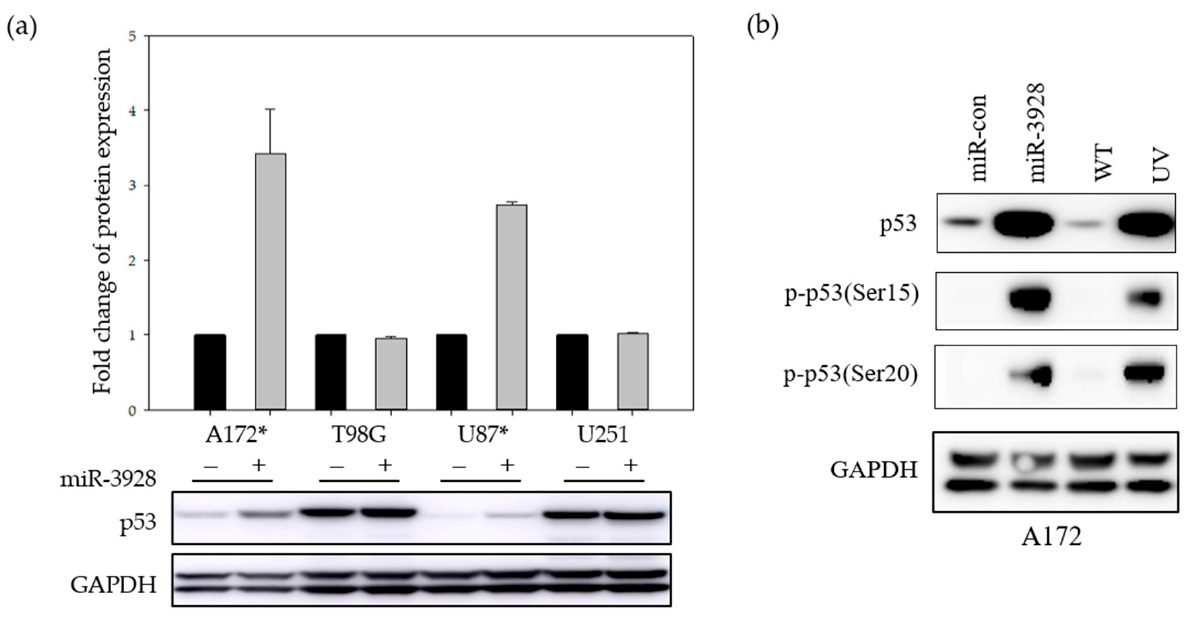
Figure 6. miR-3928 induces the expression and activation of p53 in GBM cells. ( a ) Band intensities from immunoblot replicates are quantified and graphed for A172, T98G, U87, and U251 cells transfected with either miRNA scrambled control ( − ) or miR-3928 (+). Representative immunoblot images for p53 and associated GAPDH are shown below the bar graph. Exogenously overexpressed miR-3928 leads to the upregulation of wild-type p53 in GBM cell lines A172 and U87 that have wild-type p53 (*) but not in T98G and U251 cell lines, which have mutant p53. ( b ) With immunoblots showing that miR-3928 overexpression induces p53 phosphorylation in A172 cells, UV treated cells are used as positive control for p53 phosphorylation/activation.